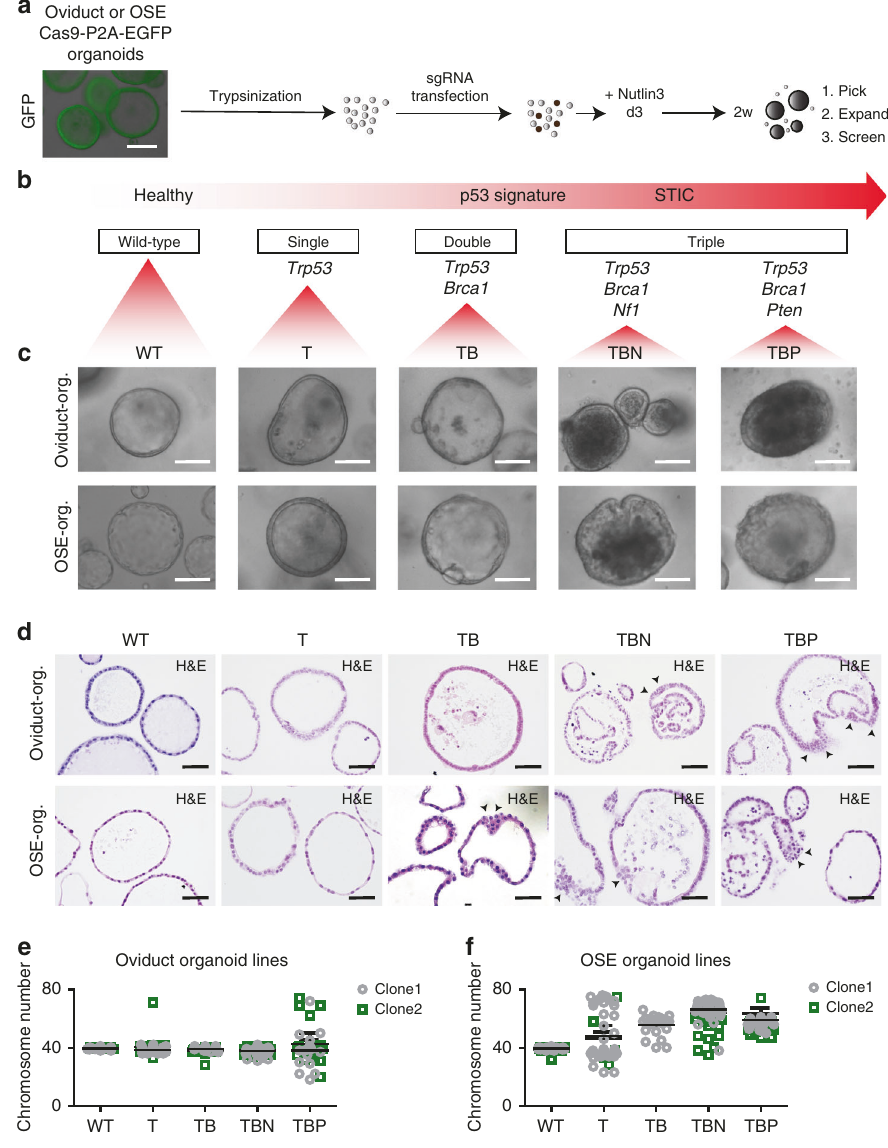
Fig. 3 CRISPR-modi fi cation of oviductal and OSE organoids. a Strategy to generate the mutant lines using CRISPR-Cas9. The lines were trypsinized to single-cell suspension followed by sgRNA transfection. Three days after transfection Nutlin-3a was added to the medium to allow mutant Trp53 organoid outgrowth. In 2 weeks emerging clonal organoids were picked, expanded and screened. Scale bar, 200 μ m. b Hypothesized tumor progression model of HG-SOC and chosen genes to build comparable progression models. STIC — serous tubal intraepithelial carcinoma. c Bright fi eld images of comparable clones with the different set of mutations from both oviductal and OSE origin. Scale bar, 100 μ m. d Immunohistochemical stainings for H&E to visualize the more detailed phenotype of oviductal and OSE clones. Arrow heads point to the cellular strati fi cation. Scale bar, 50 μ m. c , d Org. — organoids. e , f Scatter plots presenting chromosome number distribution and mean of e oviduct wild-type and mutant clones or f OSE wild-type and mutant clones, based on organoid metaphase spreads ( n = 20 spreads per biologically independent clones). c – f OSE — ovarian surface epithelium, WT — wild-type, T — Trp53 mutant; TB — Trp53, Brca1 mutant; TBN — Trp53, Brca1, Nf1 mutant; TBP — Trp53, Brca1, Pten appearance (Fig. 3c). This morphological difference was con- fi rmed by hematoxylin and eosin (H&E) stainings where the both oviductal and OSE origins with two independent clones for each combination of mutations. All the clones and their triple mutants exhibited more irregular shapes and cellular mutations are summarized in the tables under the Supplementary strati fi cation (Fig. 3d). In order to study the effect of different Fig. 1b. mutations on organoid growth speed, we closely monitored the expansion of the organoids by measuring the size of the organoids daily for a week (Supplementary Fig. 2d-e). In the oviductal lineage, we observed that all the mutation combinations induced signi fi cantly faster growth rate of the clones compared with the corresponding WT organoids (Supplementary Fig. 2d). In (TBN and TBP) from both origins displayed a denser and folded contrast, the growth rate of the OSE clones was largely unaffected